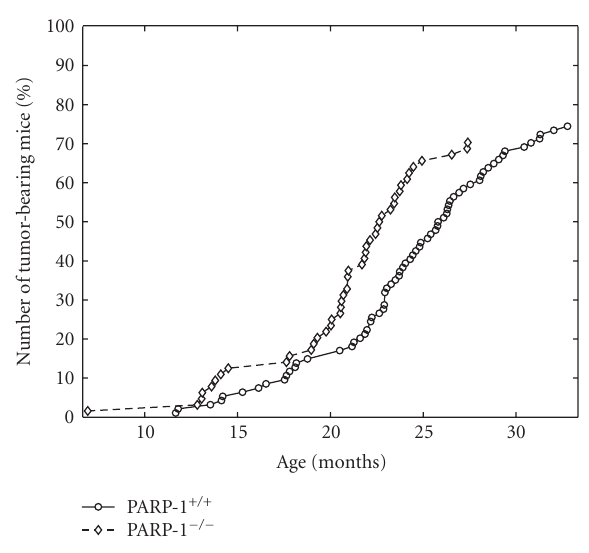
Figure 8: Total tumor yield curves for PARP-1 − / − and PARP-1 + / + mice. Number of tumor-bearing mice in each group were presented as percentage as a function of